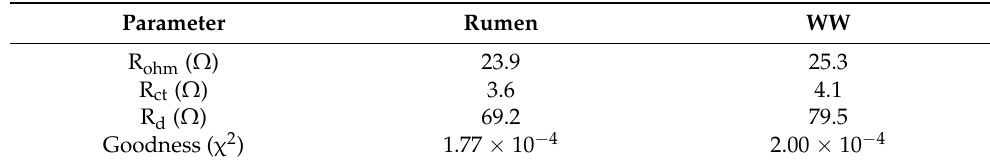
Table 2. Values of ohmic (R ohm ), charge transfer (R ct ), and diffusion (R d ) resistance calculated by fitting experimental data with an equivalent circuit using χ 2